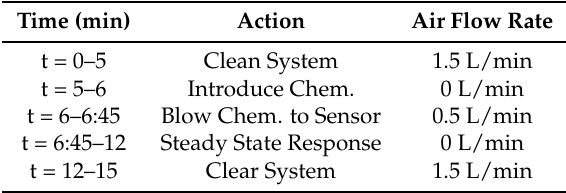
Table 2. Timing and flow control for the chamber.